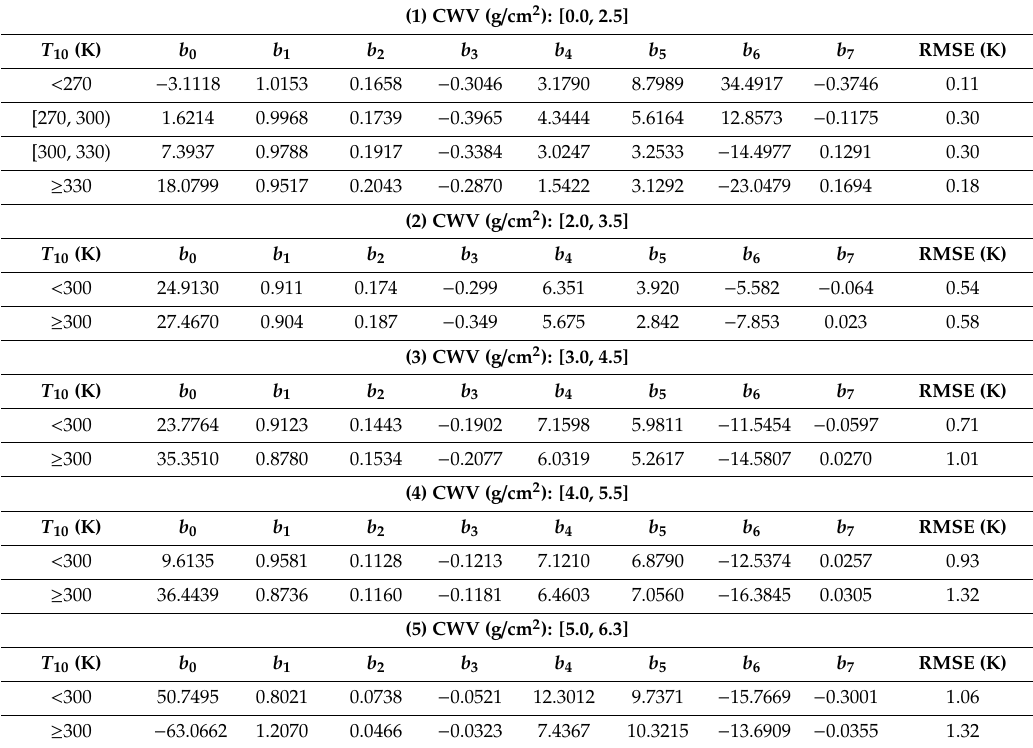
Table 1. The coe ffi cients b k in di ff erent column water vapor (CWV) and brightness temperature of Band 10 ( T 10 ) intervals, and root-mean-square error (RMSE) of the predicted